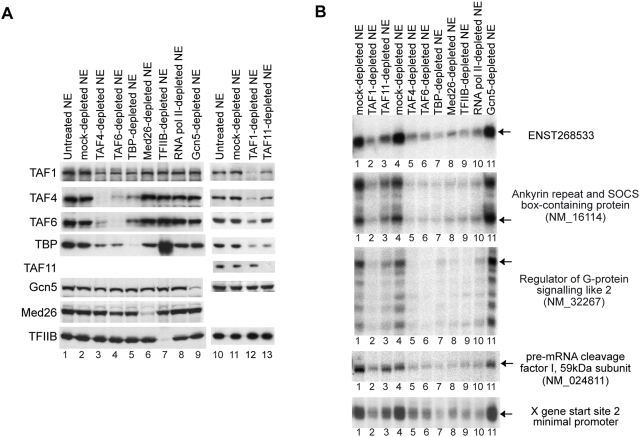
XCPE1 and XCPE2-containing cellular promoters show the same GTF requirements as HBV X gene promoter.(A) Western blot analyses of depleted NEs. HeLa NE was immunodepleted as indicated and the levels of target factors as well as other GTFs were examined by western blotting. (B) In vitro transcription assays of the immunodepleted NEs. Transcription activities for the XCPE2-containing promoters (ENST268533, NM_16114, and NM_32267), an XCPE1-containing promoter (NM_024811), and the X gene Start site 2 minimal promoter were examined. Arrows show the transcripts starting at the positions expected to be driven by XCPE2 or XCPE1.